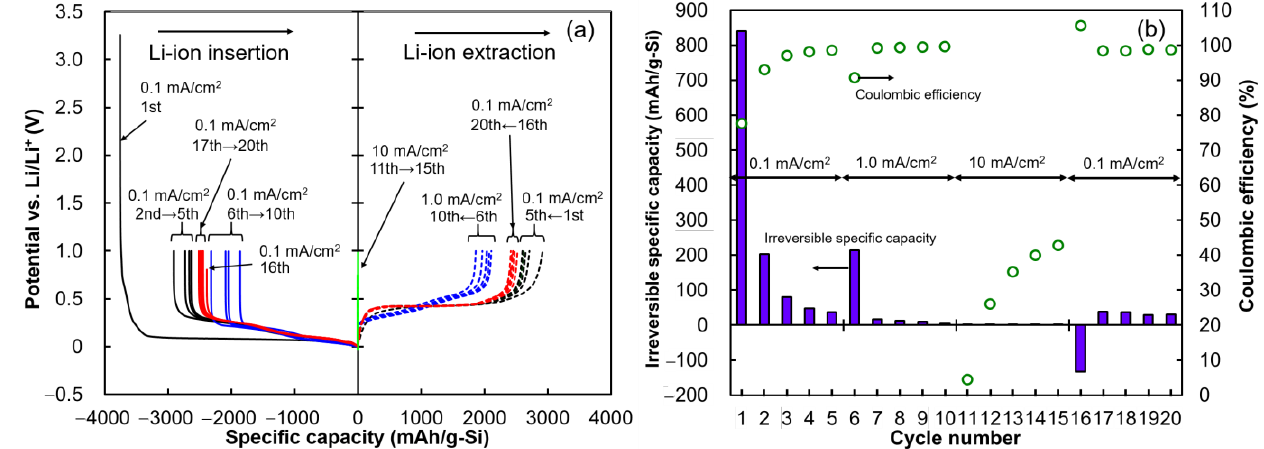
Figure 7. Fundamental Li-ion insertion and extraction properties of the Si anode in the half-cell configuration. ( a ) Potential–specific capacity profile and ( b ) irreversible specific capacity and Coulombic efficiency of the Si anode during Li-ion insertion/extraction cycles at different current densities.